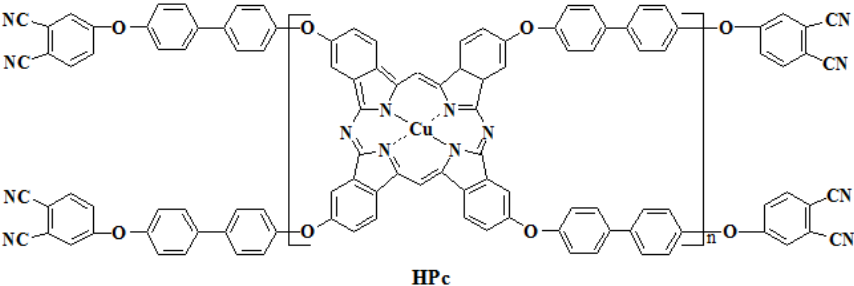
Figure 1. Chemical structure of hyperbranched copper phthalocyanine polymer (HPc). Aromatic dialdehyde, bis(4-formylphenyl) phenylphosphonate, was prepared by the reaction of phenyl phosphonic dichloride and 4-hydroxybenzaldehyde according to a method previously described